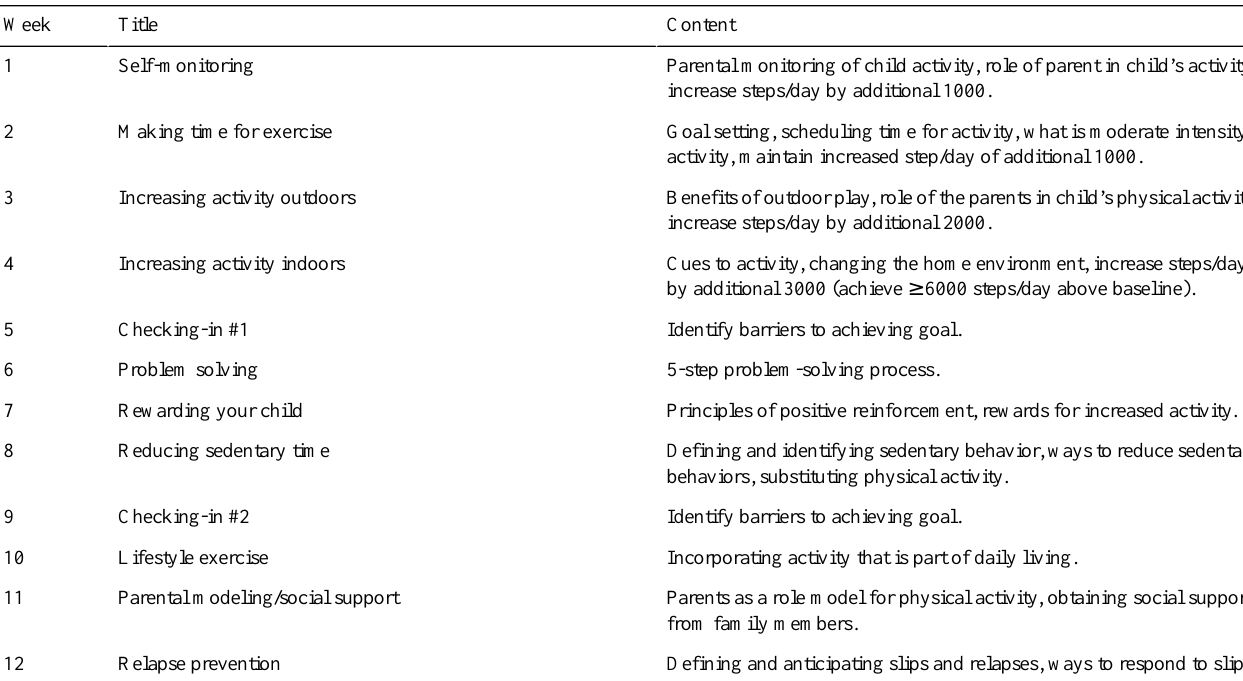
Table 2. Behavioral articles provided to parents in the intensive intervention group (IIG).